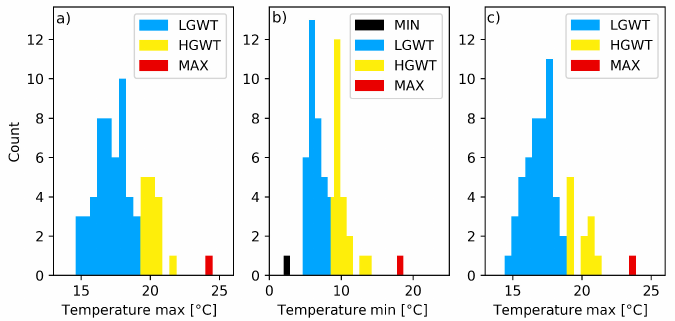
Figure 5. Histograms of the GWT in each observation well during summer 2004 ( a ), winter season 2004/2005 ( b ) and summer 2005 ( c